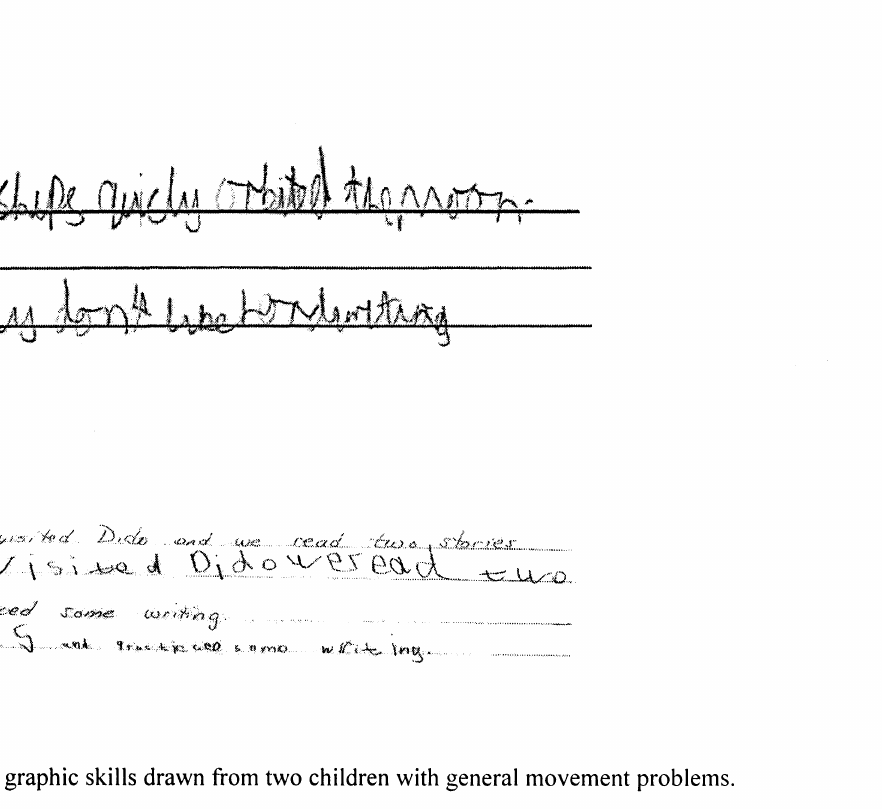
Fig. 1: Examples o.f defective graphic skills drawn from two children with general movement